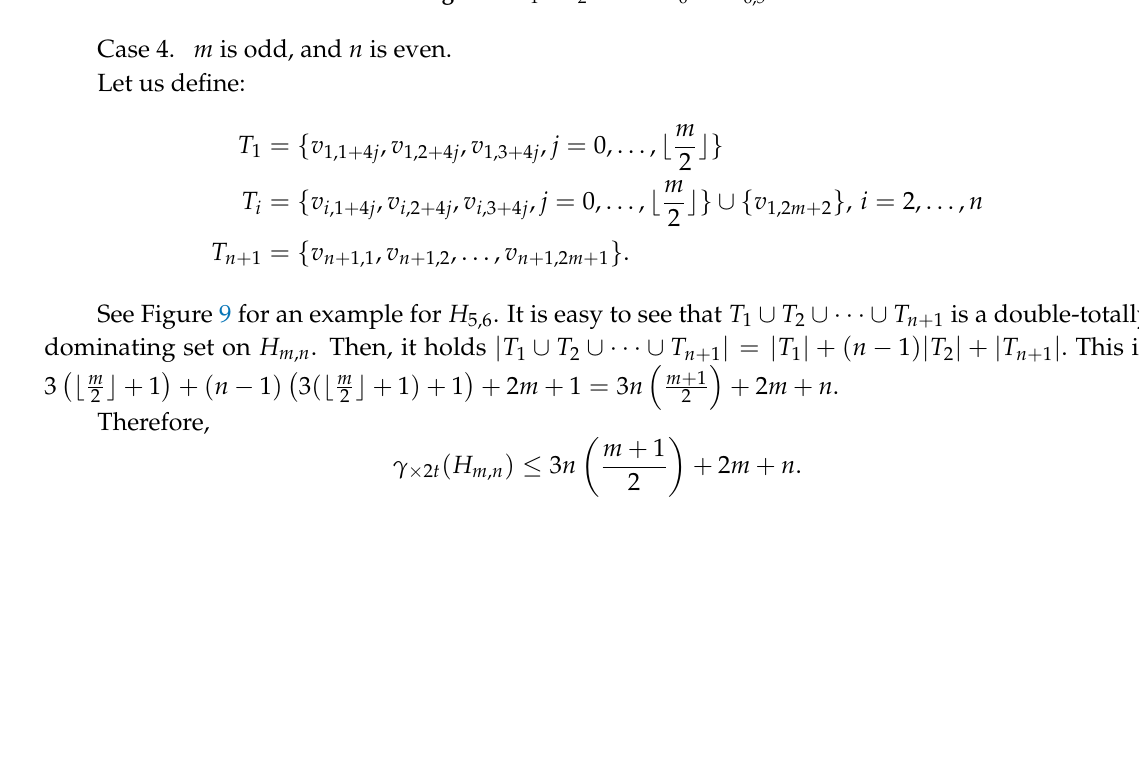
Figure 8. T 1 ∪ T 2 ∪ · · · ∪ T 6 on H 6,5